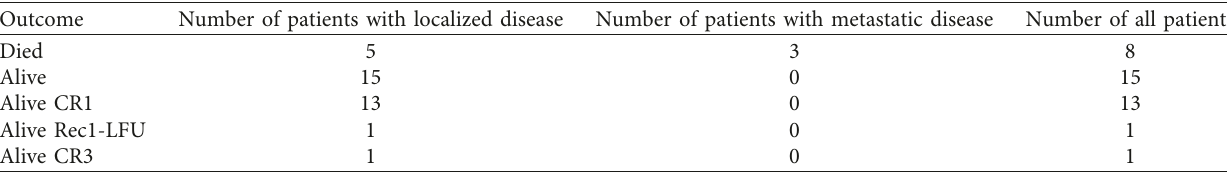
Table 5: Outcome at the last follow-up.